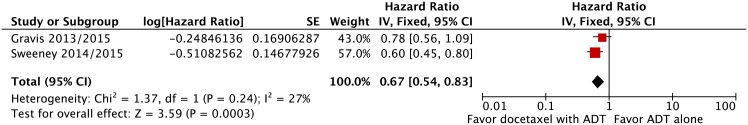
Comparative effect in overall survival of ADT with docetaxel versus ADT alone in patients with high-volume disease.Abbreviations: ADT, androgen-deprivation therapy; CI, confidence interval.